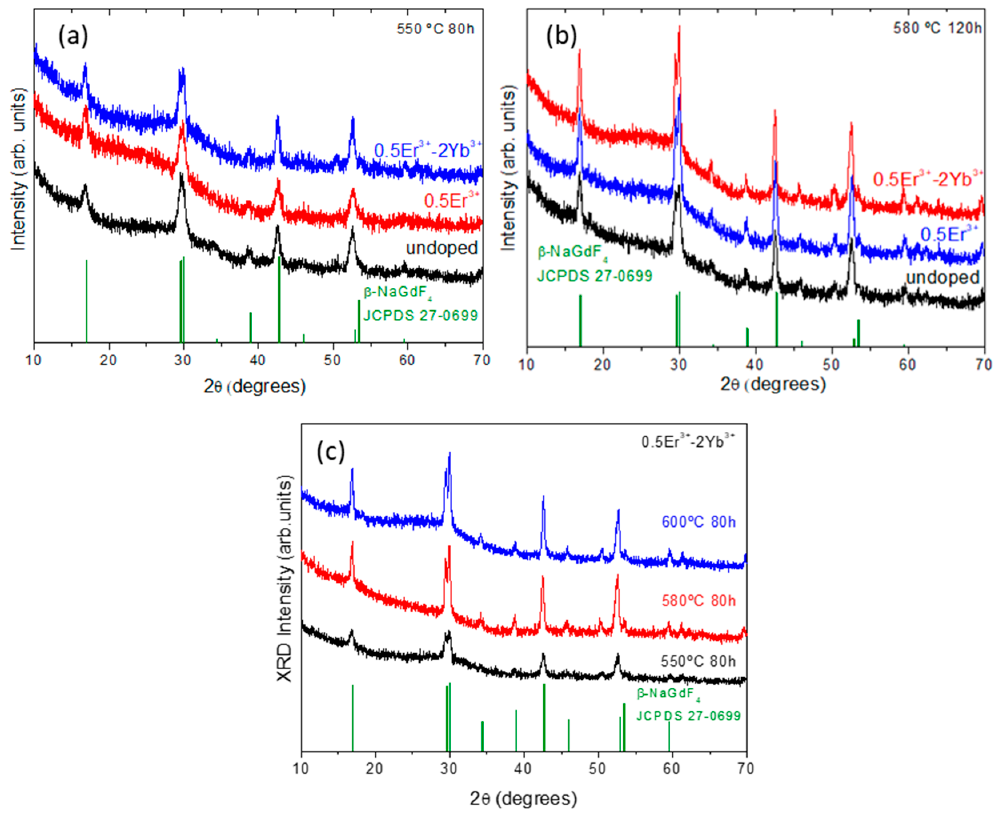
Figure 2. ( a ) XRD patterns for undoped, Er 3+ -doped and Er 3+ –Yb 3+ -codoped 70Si7Gd GCs treated at 550 °C-80 h and ( b ) 580 °C-120 h; ( c ) XRD patterns of 0.5Er–2Yb-codoped 70Si7Gd GCs at different treatment temperatures for 80 h. Table 2. Nanocrystals medium size, in nm, of undoped, Er 3 + -doped and Er 3 + –Yb 3 + -codoped 70Si7Gd GCs treated at di ff erent temperatures and dwelling